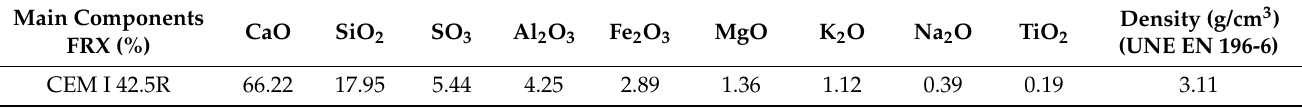
Table 1. OPC main components and